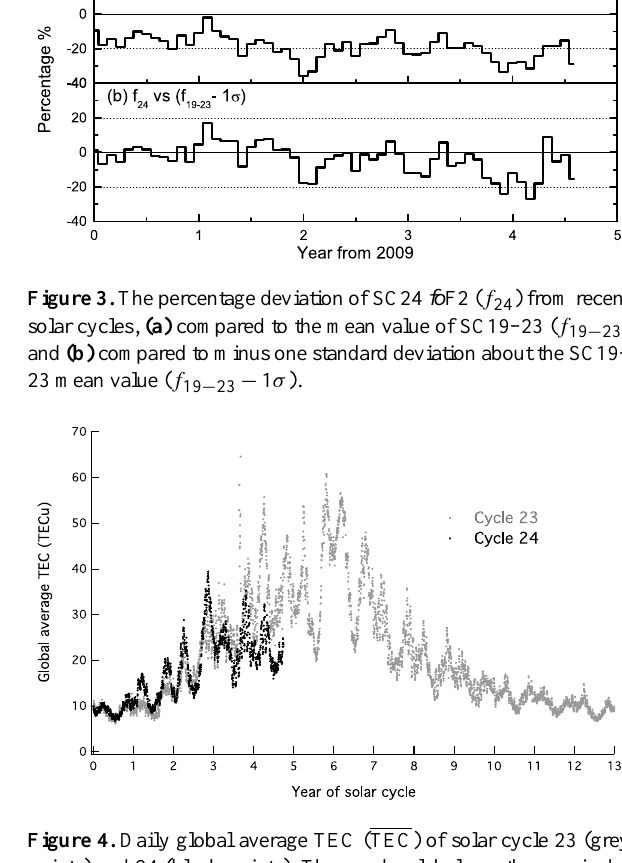
Figure 4. Daily global average TEC (TEC) of solar cycle 23 (grey points) and 24 (black points). The number labels on the x axis de- note the year counted from the beginning of each solar cycle.